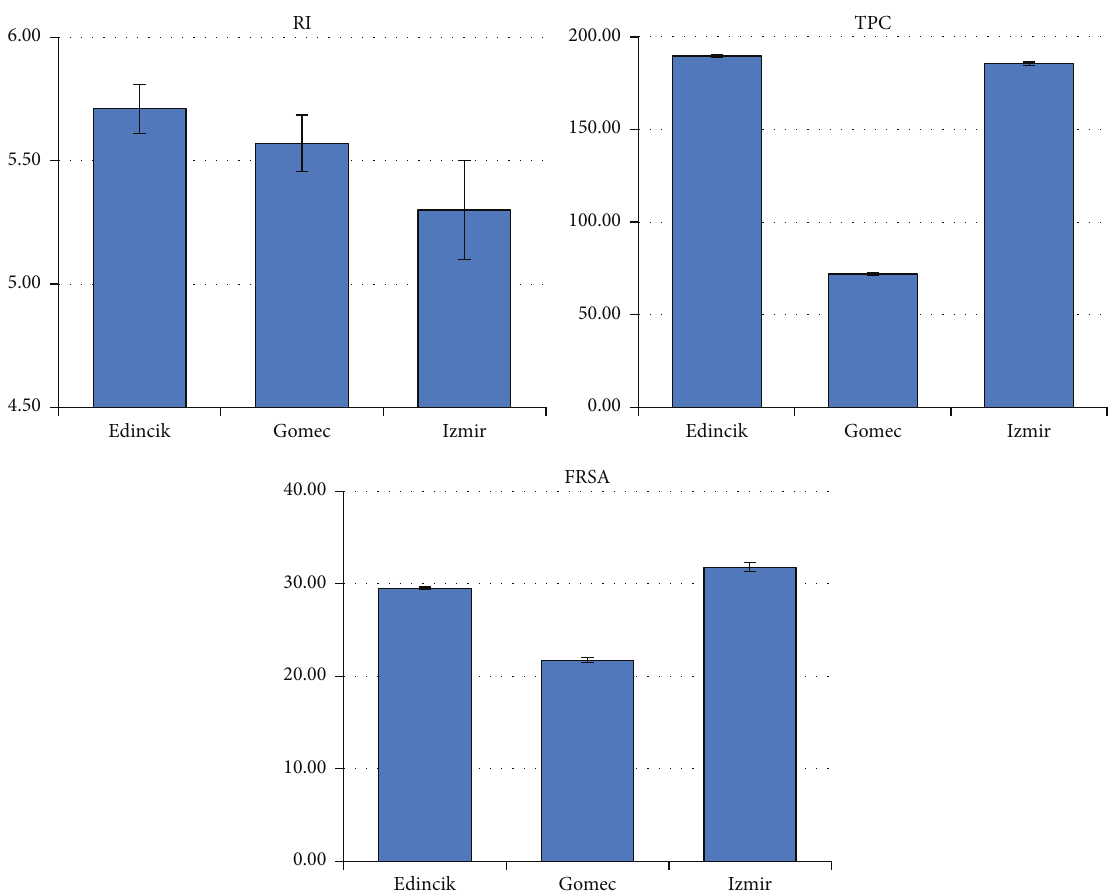
Figure 2: RI: ripeness index of olive fruits, TPC: total phenolic content (mg gallic acid equivalent/kg oil) of virgin olive oils, and FRSA: free radical scavenging activity (% inhibition of DPPH ∙ radical) of virgin olive